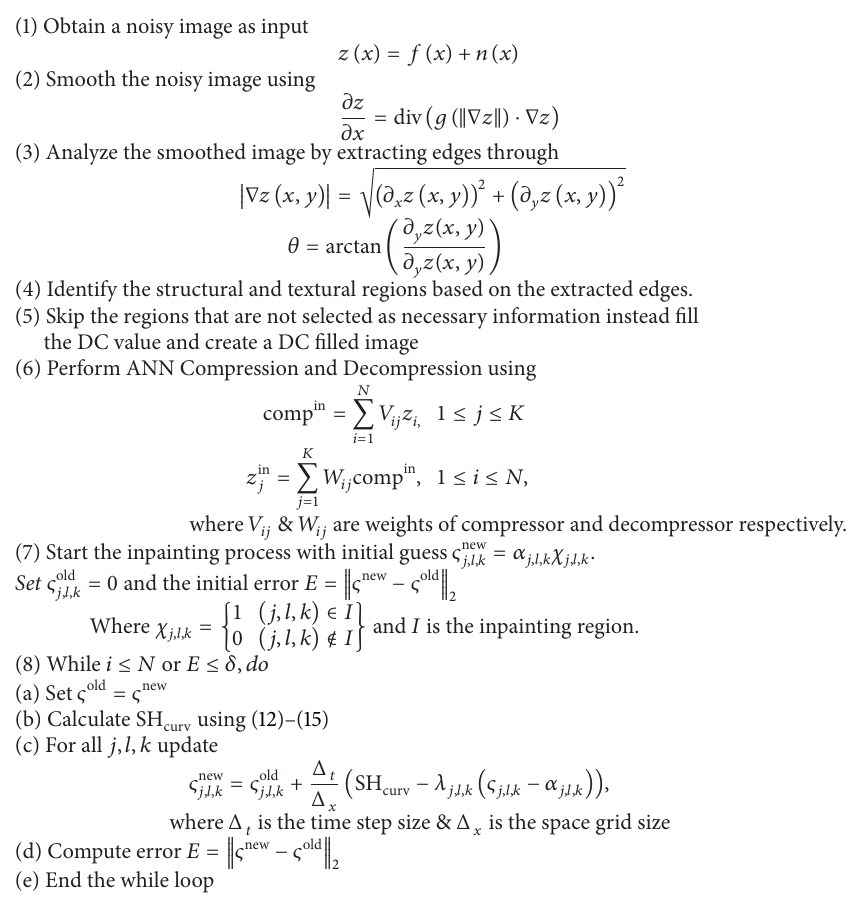
Algorithm 2: Construction of discrete shearlet